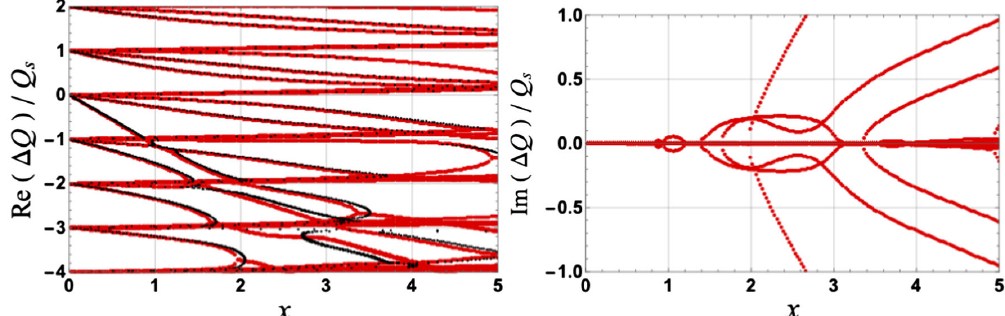
τ 2 . 8 ) and for a WB longitudinal such that f r r b ¼